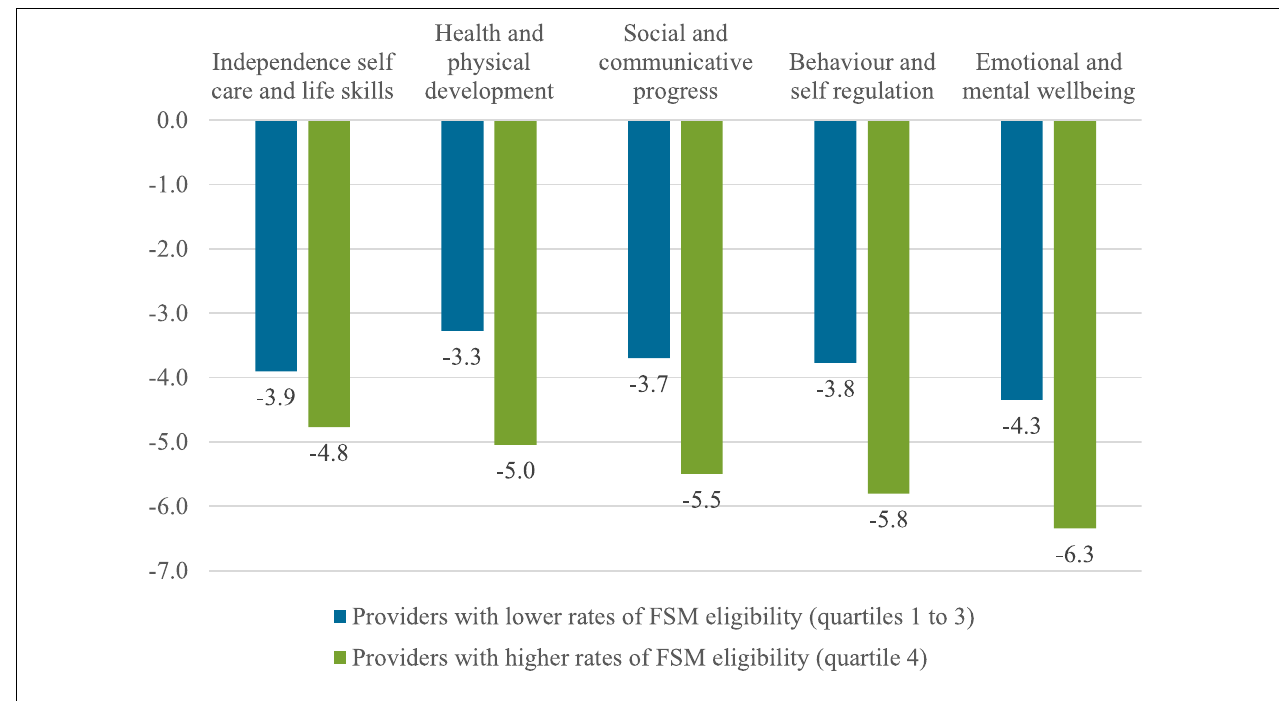
FIGURE 2 | Mean reported developmental losses for pupils in specialist provision (in months) by FSM eligibility. Base: 190 respondents . 56 respondents were in the top quartile for FSM eligibility.